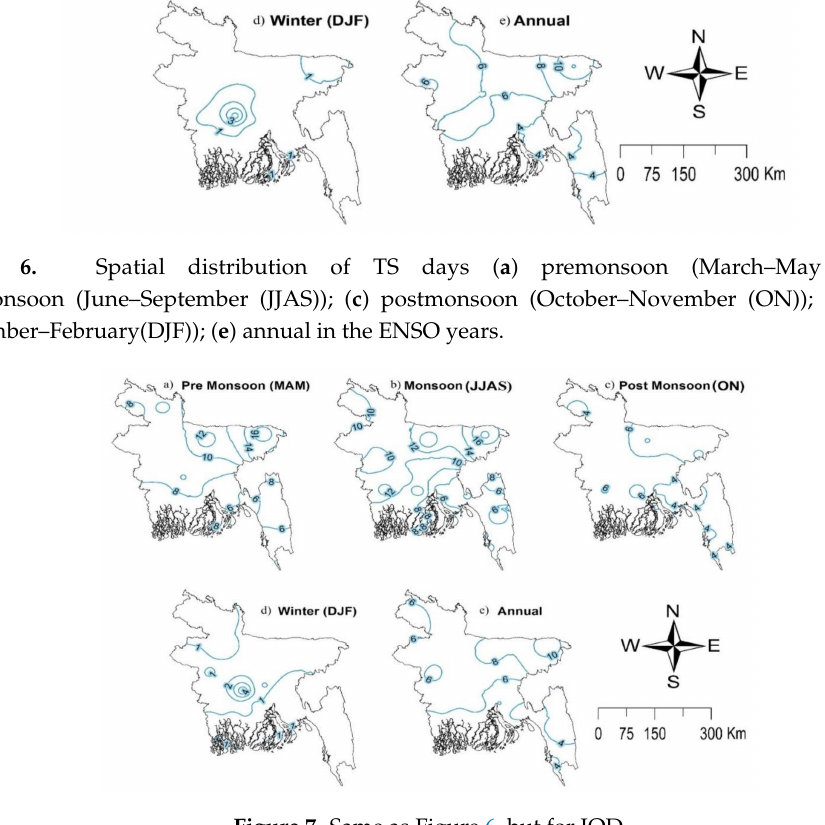
Figure 7. Same as Figure 6, but for